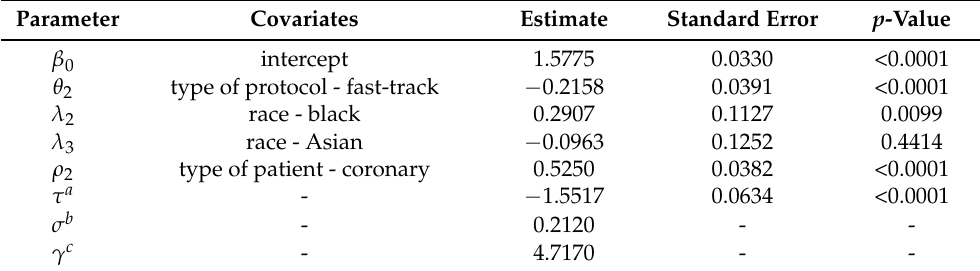
Table 5. Weibull regression model parameter estimates (after model selection).